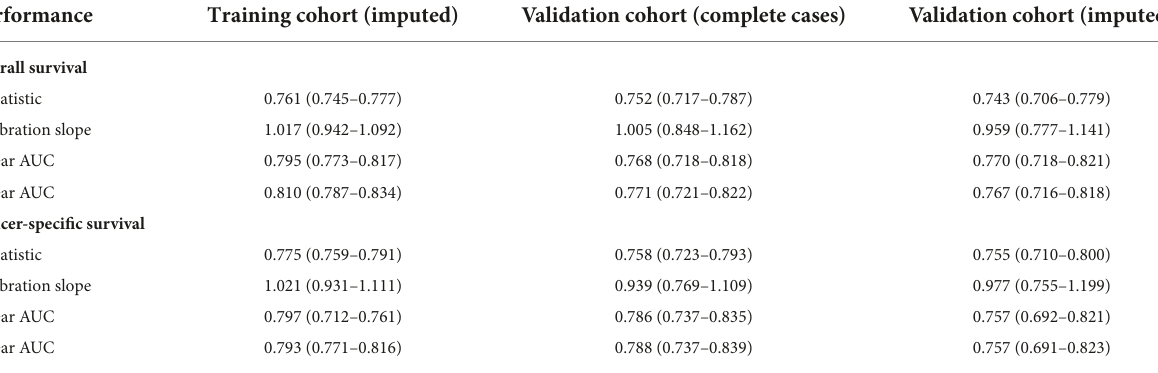
TABLE 4 Performance metrics of the final overall survival and cancer-specific survival models in predicting patient survival outcome within the imputed training cohort, the complete cases of the validation cohort, and the imputed validation cohort. Performance Training cohort